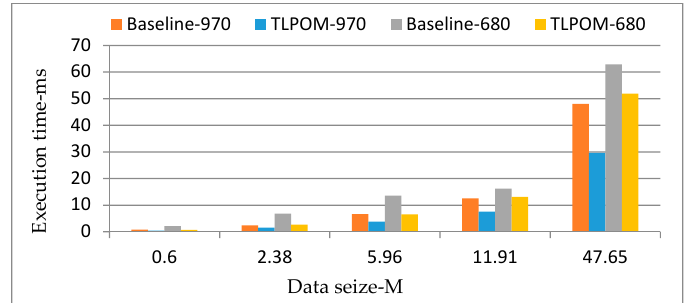
Figure 14. The performance of KM with different data size.